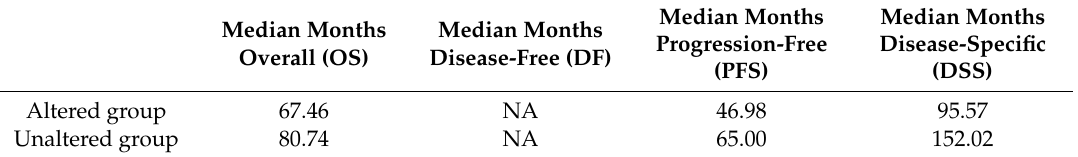
Figure 2. Red: altered group; blue: unaltered group; we observed that mutations in the 5FU converting system influenced the overall survival ( p = 0.0163), the disease-free survival ( p = 0.0114), the progression-free ( p = 0.000197), and the disease-specific curves ( p = 0.00679); data retrieved from 32 studies including 10953 patients, TCGA PanCancer Atlas. Table 1. Patients were divided into two groups: one with at least one mutation in the 5FU converting system defined as the altered group and one with the Wt allele version, the unaltered group. We observed significant modification in all the four examined parameters, i.e., the OS, the DF, the PFS, and the DSS in the group bearing mutations.